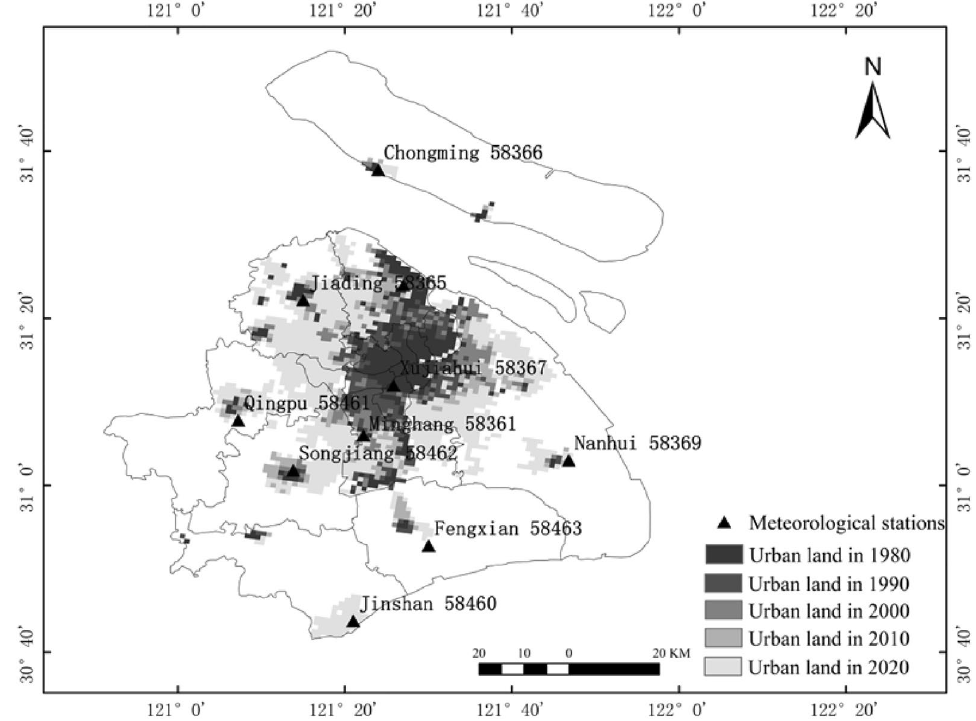
Figure 1. Study areas and meteorological